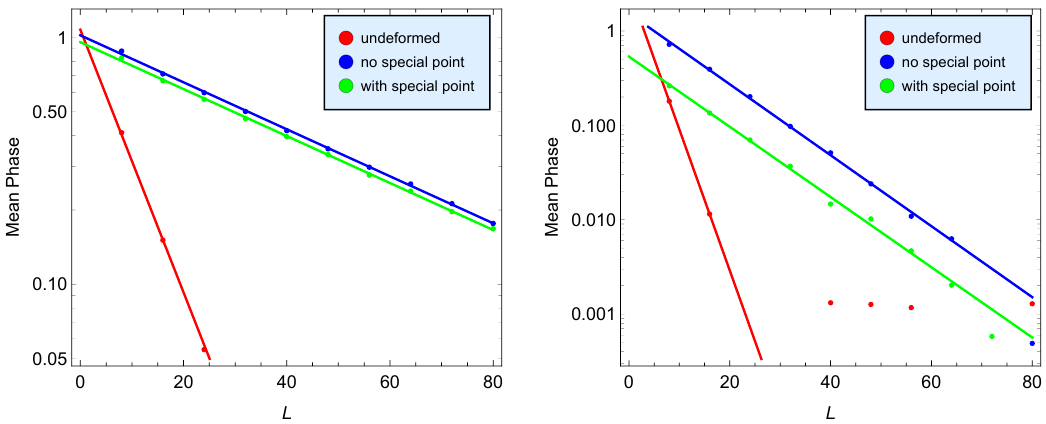
Figure 3 . The mean phase factor as a function of lattice size for µ = 1 (left) and µ = 1 . 5 (right) on a logarithmic scale. We compare the results of the old algorithm, which treats all point uniformly, the new algorithm that treats one point differently, and the undeformed contour. We observe that the linear fit works very well in all cases, as long as we do not include in the fit points with